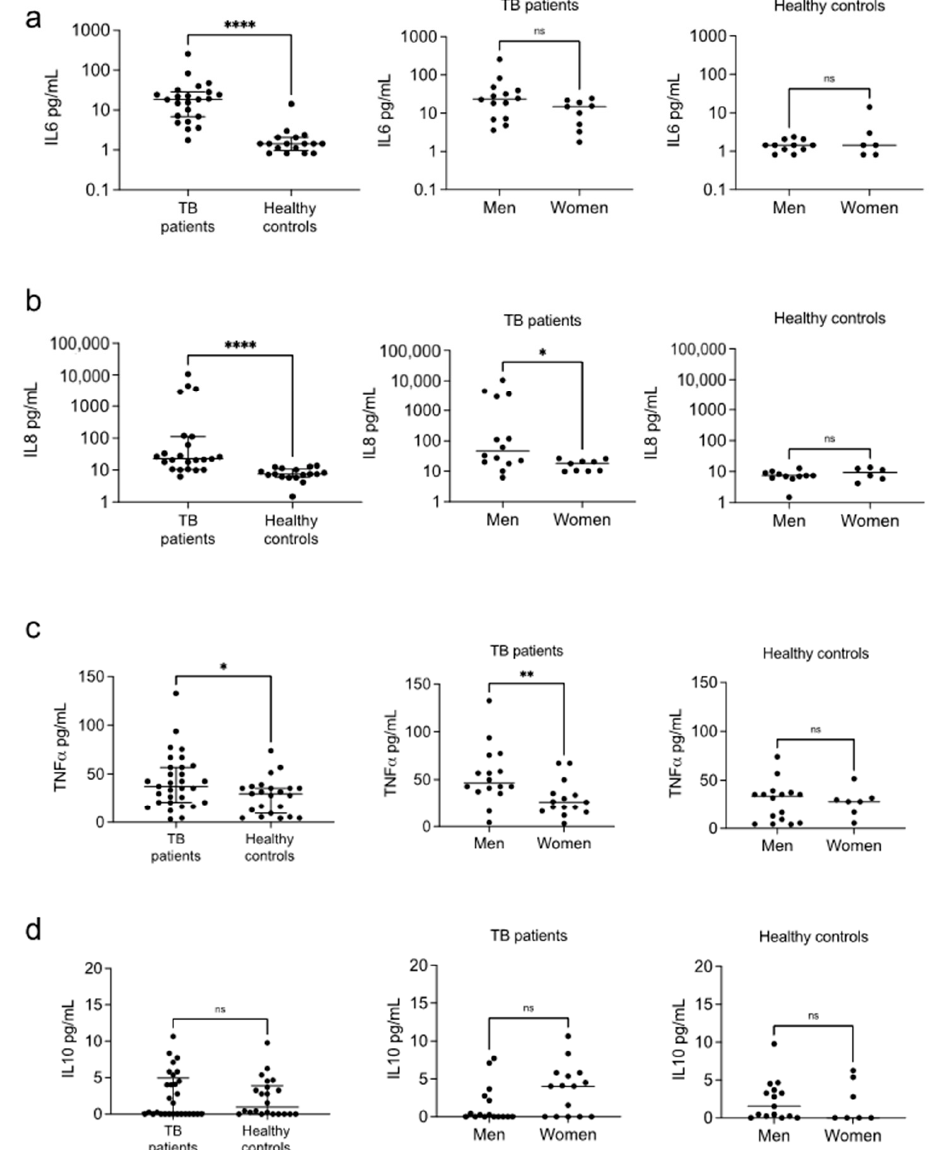
Figure 2. Circulating levels of cytokines. Serum levels of IL6 ( a ), IL8 ( b ), TNF α ( c ), and IL10 ( d ) were measured in patients with pulmonary tuberculosis and healthy controls using a Bioplex system. Individual results with medians and interquartile ranges are depicted ( left ). Data were disaggregated by sex for both the patients ( center ) and controls ( right ); individual results with medians are depicted. * p < 0.05, ** p <0.01, **** p < 0.0001, ns = not significant.